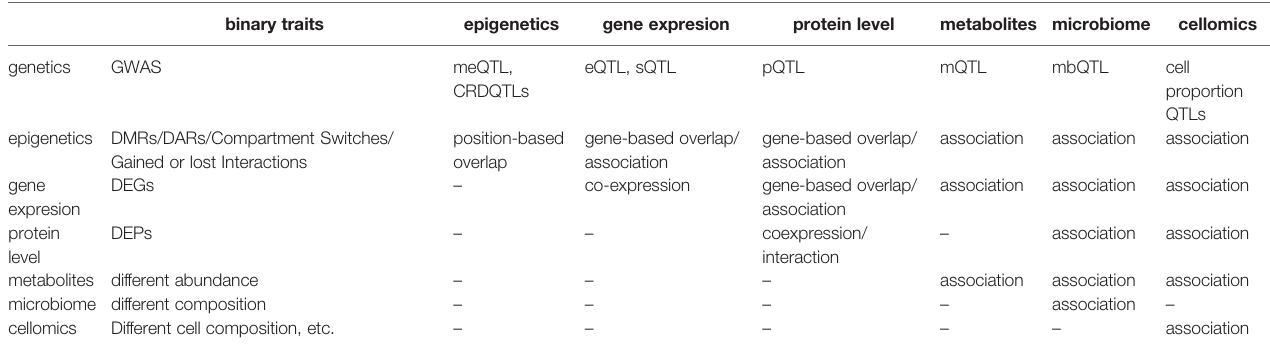
TABLE 2 | System analysis between